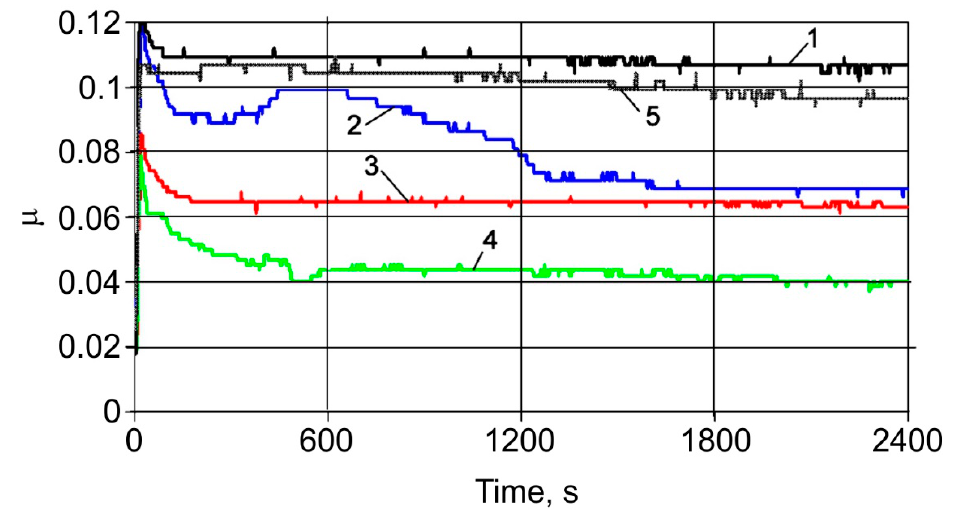
Figure 12. Changes in momentary coefficients of friction for MMC tested: 1—FeGr2; 2—1 wt% of Al 2 O 3 additive, 3—1 wt% of SiC additive, 4—0.33 wt%C + 0.33 wt% Al 2 O 3 + 0.33 wt% SiC additives, 5—FeGr1 base material.